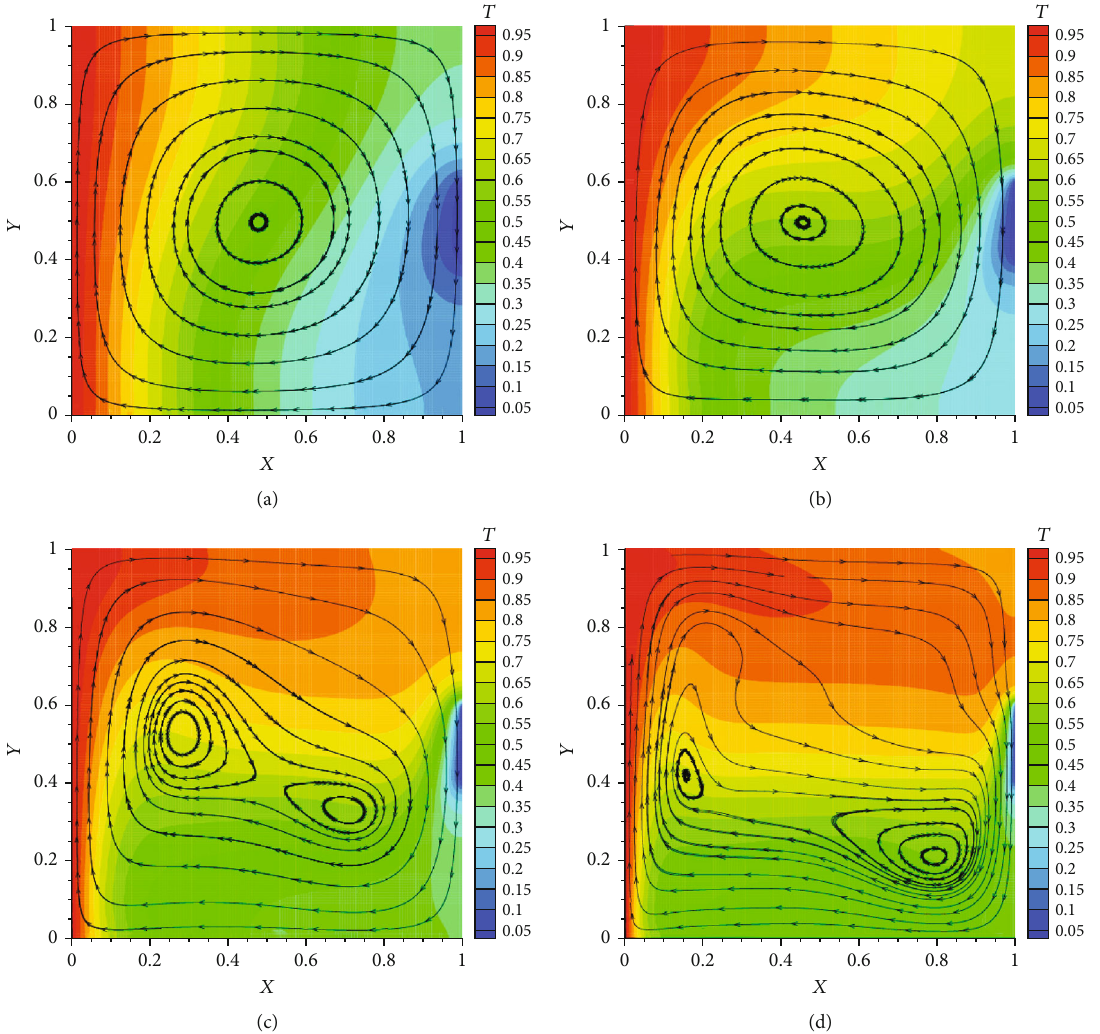
Figure 5: Streamlines overlaid on the temperature contours for (a) Ra = 10 3 , (b) Ra = 10 4 , (c) Ra = 10 5 , and (d) Ra = 10 6 , and h / H = 1/5 for cold chip.